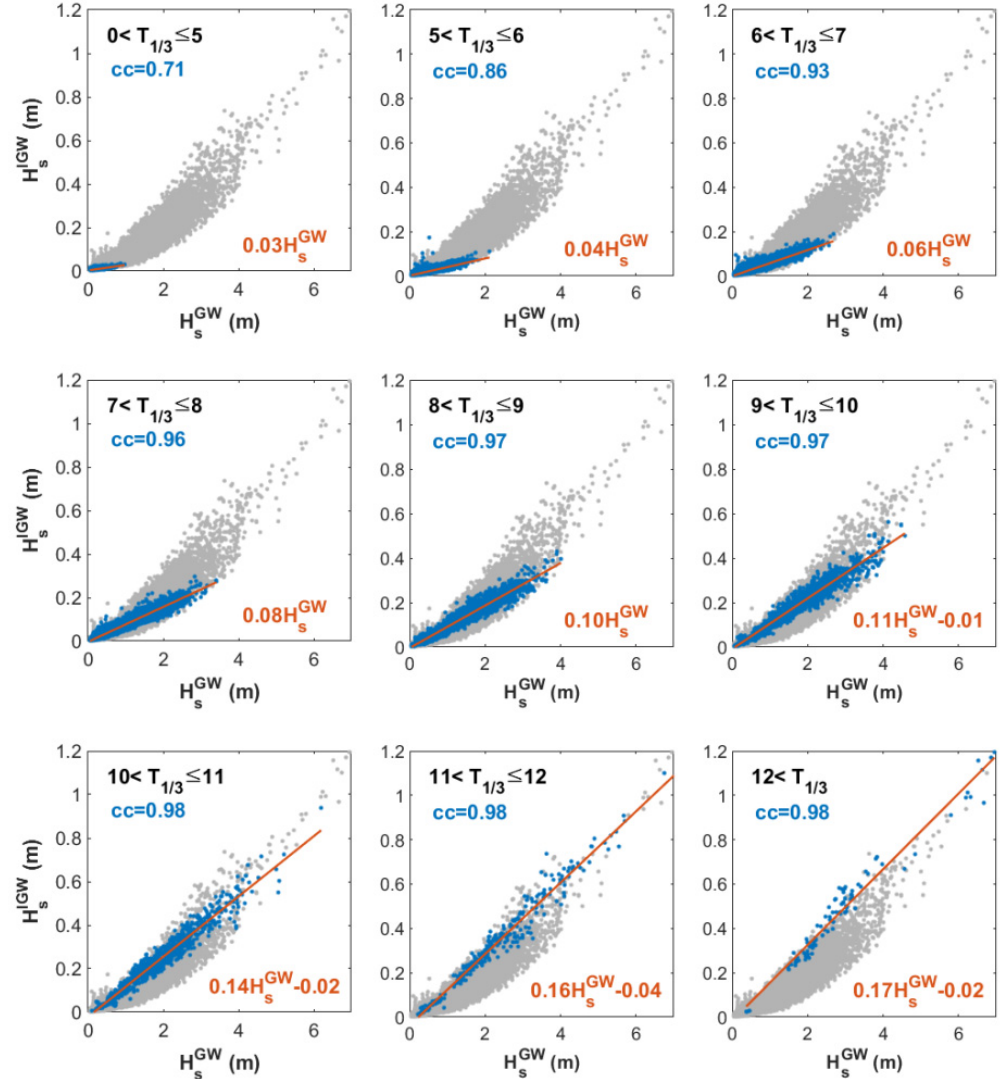
GW IGW s and H s for the nine classes depending on T 1/3